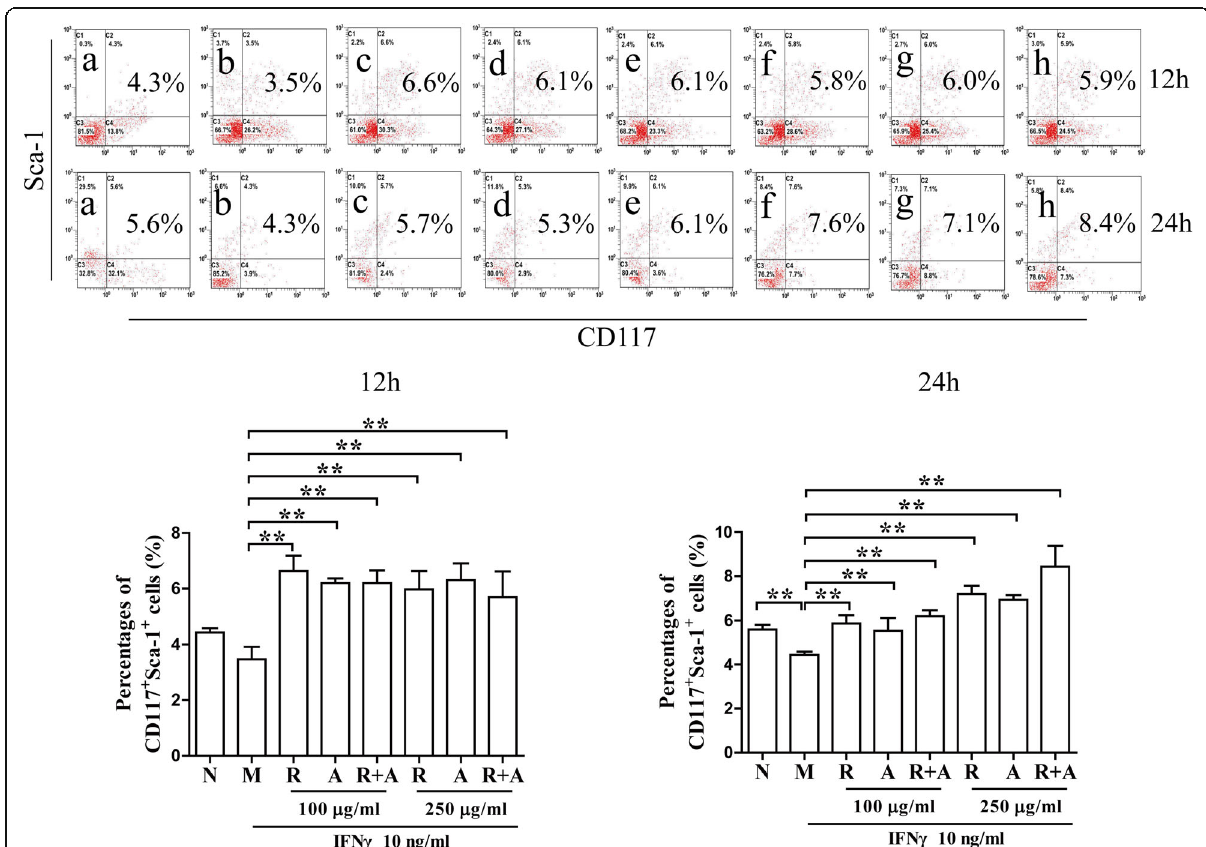
Fig. 2 Effects on the proliferation of CD117 + Sca-1 + HSCs in IFN- γ -induced BM cells after 12 and 24 h of treatment. The results are presented in bar charts. a, Normal (N) group; b, Model (M) group; c and f, Radix Astragali (R) group; d and g, Radix Angelicae Sinensis (A) group; e and h, Radix Astragali + Radix Angelicae Sinensis (R + A) group; c, d and e were treated with 100 μ g/mL of freeze-dried powder and f, g and h were treated with 250 μ g/mL of freeze-dried powders. The results are presented in a bar chart. Data are the presented as mean ± SD, n = 3. * P < 0.05 and ** P <